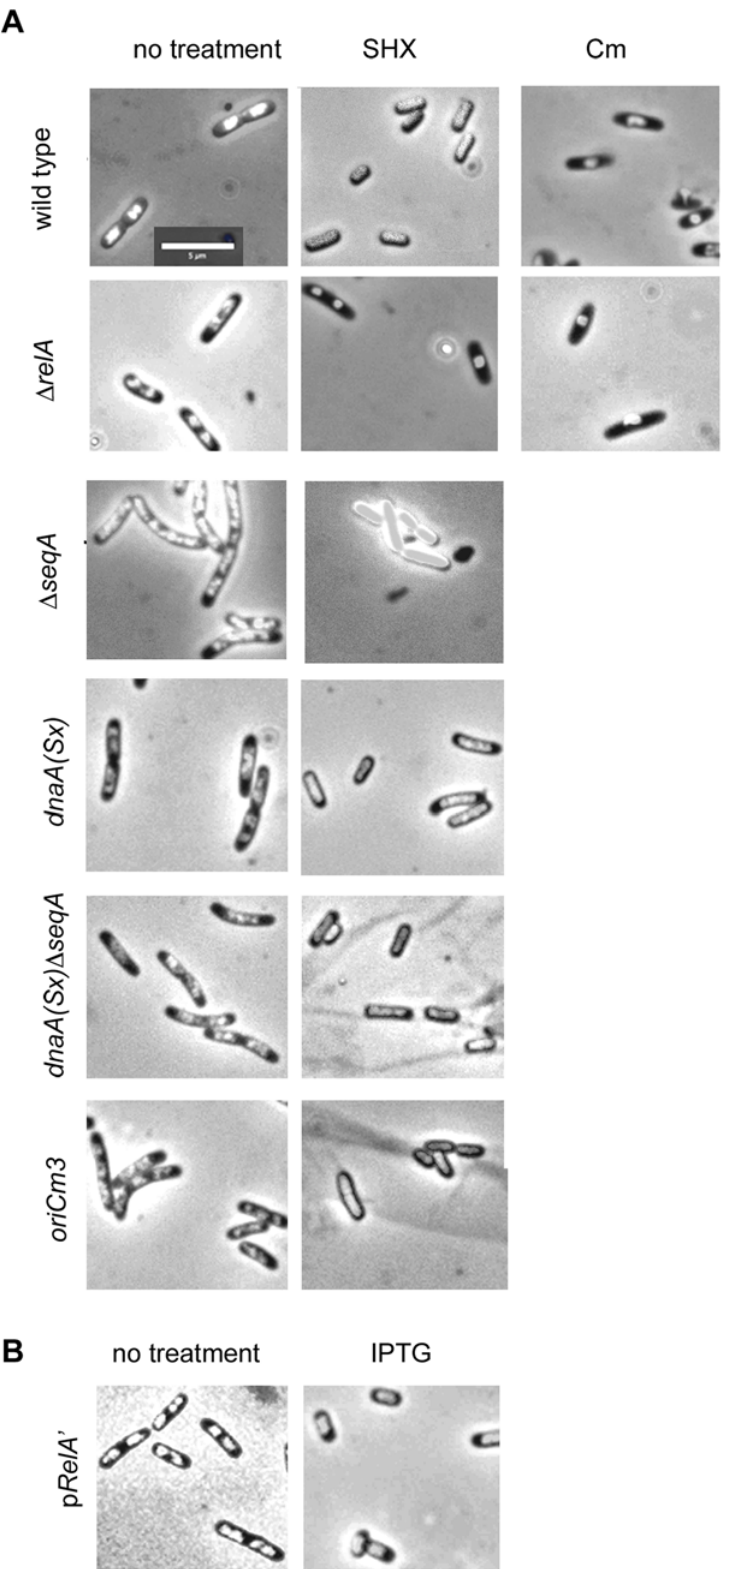
Figure 4. Nucleoids of stringent cells. Cells stained with DAPI from cultures taken before and after induction of the stringent response. Cells were grown in M9 glucose CAA medium, fixed, and stained as described in Materials and Methods. (A) Wild type and mutant cells before (left panel) and after treatment with serine hydroxamate for 1.5 h (middle panel), and, in the case of wild type and D relA cells, 300 m g/ml chloramphenicol for 1.5 h (right panel). (B) MG1655 cells harboring pRelA 9 before (left panel) and after (right panel) induction with IPTG.